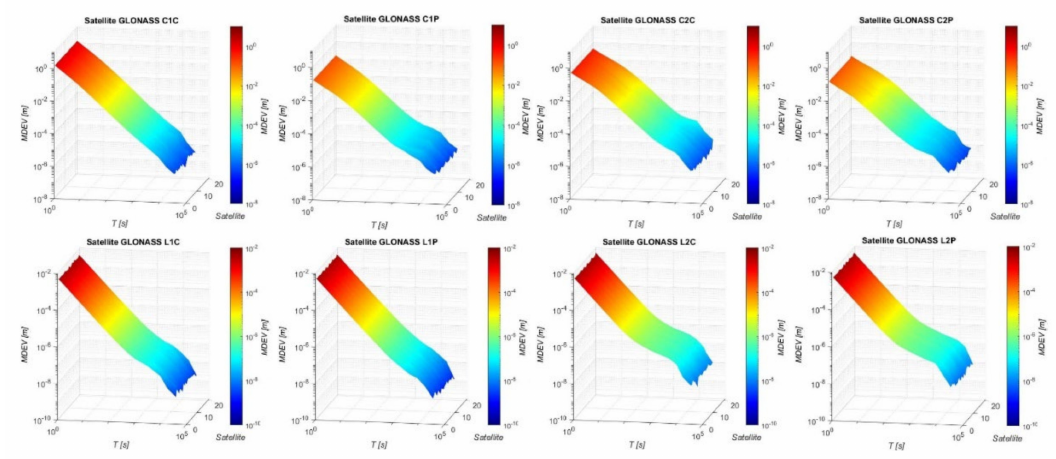
Figure 13. MDEV of the analyzed observation type for GLONASS satellites.